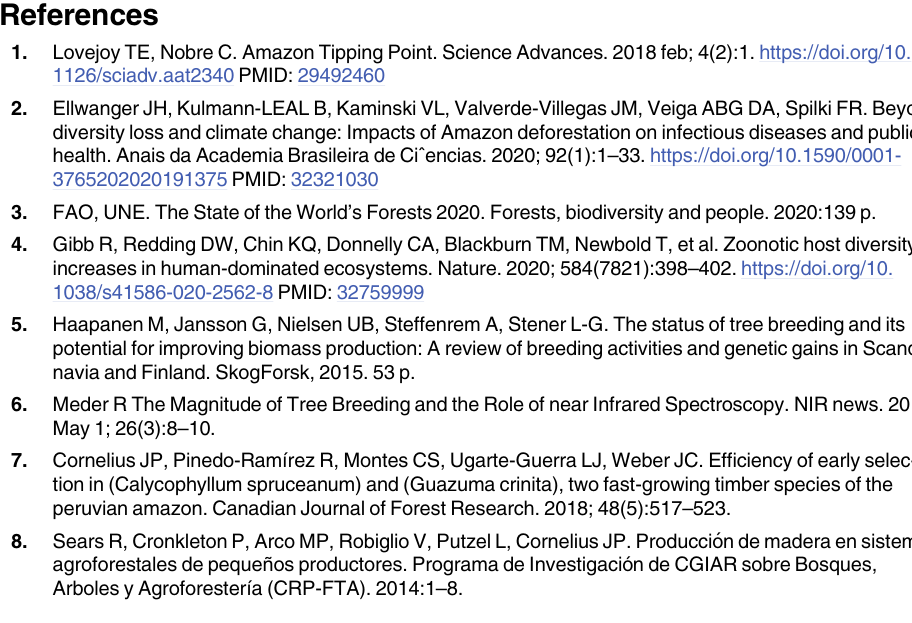
S2 Table. Leave-one-out cross validation method and number of latent variables determi-